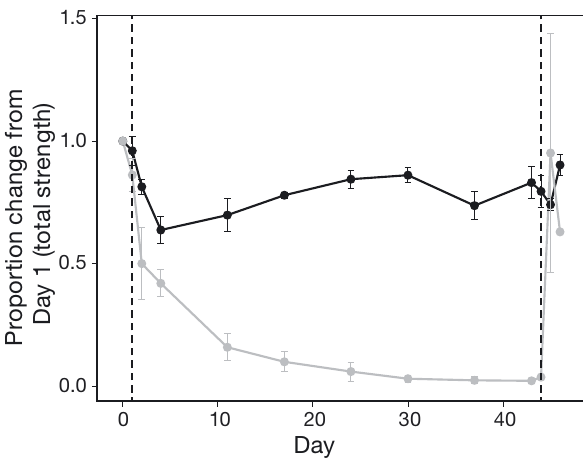
Fig. 2. Proportion change in echo strength for the control (black) and submerged (grey) salmon cages. Data are means ± SE recorded 13 times throughout the experimental period. Vertical dashed lines represent submergence and resurfac- ing of submerged cages; n = 3, except for the last time point for submerged cages when n = 1 due to hardware